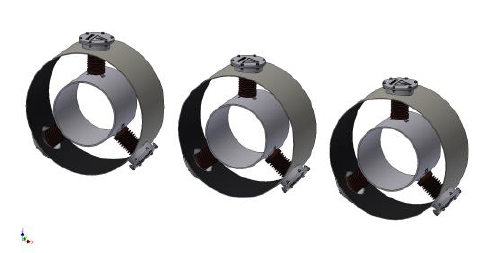
Fig. 1. Three-phase flat high-current busduct with isolated phases manufactured by the Holduct company (Myslowice, Poland).